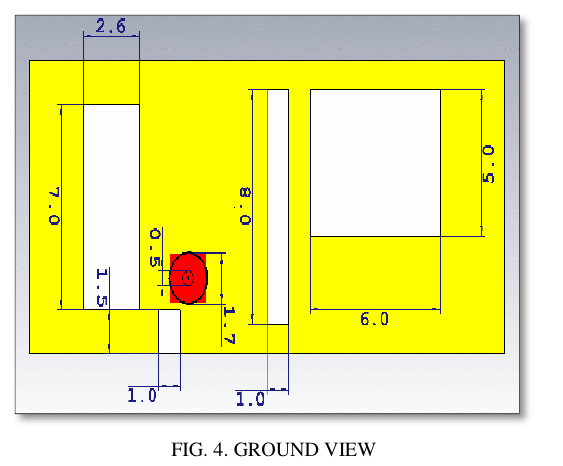
FIG. 5. RETURN LOSS VERSUS